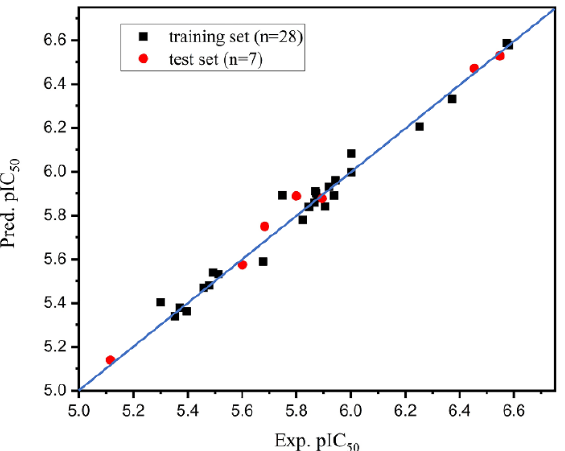
Figure 2. Plot of the experimental and predicted values for training and test set compounds using Topomer CoMFA model.